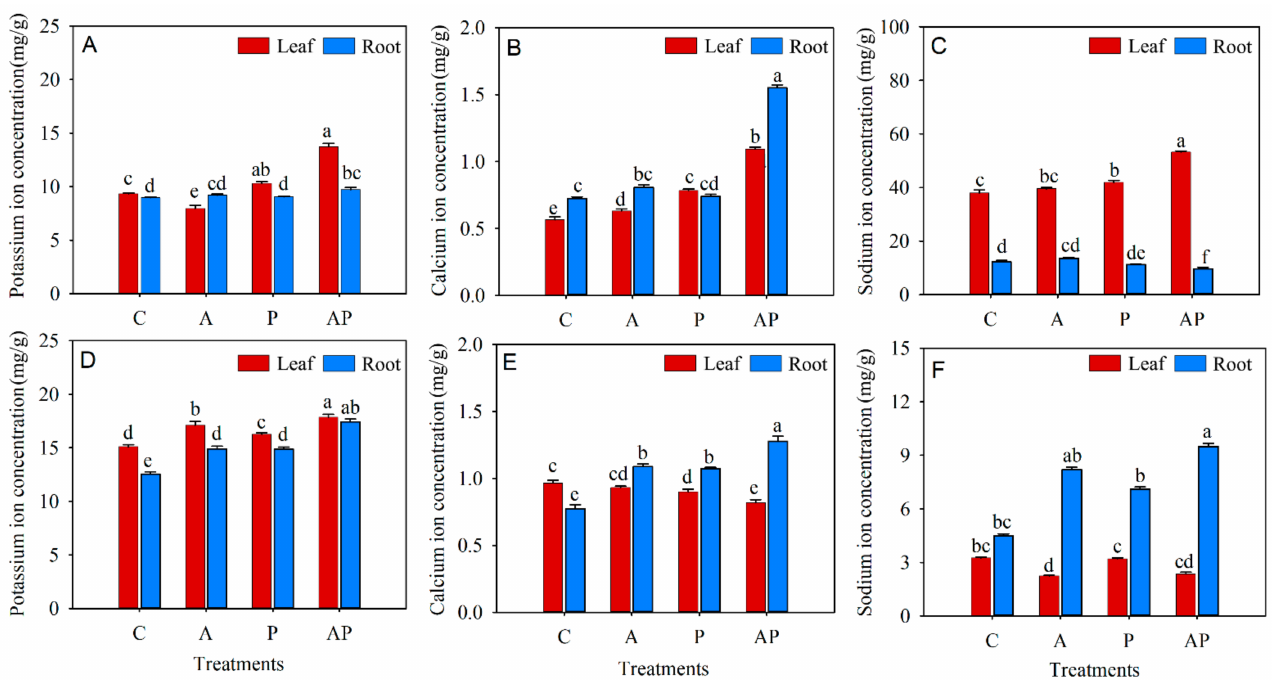
Figure 5. Effects of AMF and PGPR inoculation on the K + ( A , D ), Ca 2+ ( B , E ), and Na + ( C , F ) concen- trations in Nitraria tangutorum Bobr. (first row) and Elaeagnus angustifolia Linn. (second row). Each value represents the mean of three replicates. Each bar represents the standard deviation of three replicates. Values are significantly different at the 0.05 level (Tukey’s test) if followed by different letters above the bars. C: control, A: AMF inoculation treatment, P: PGPR inoculation treatment, AP: co-inoculation